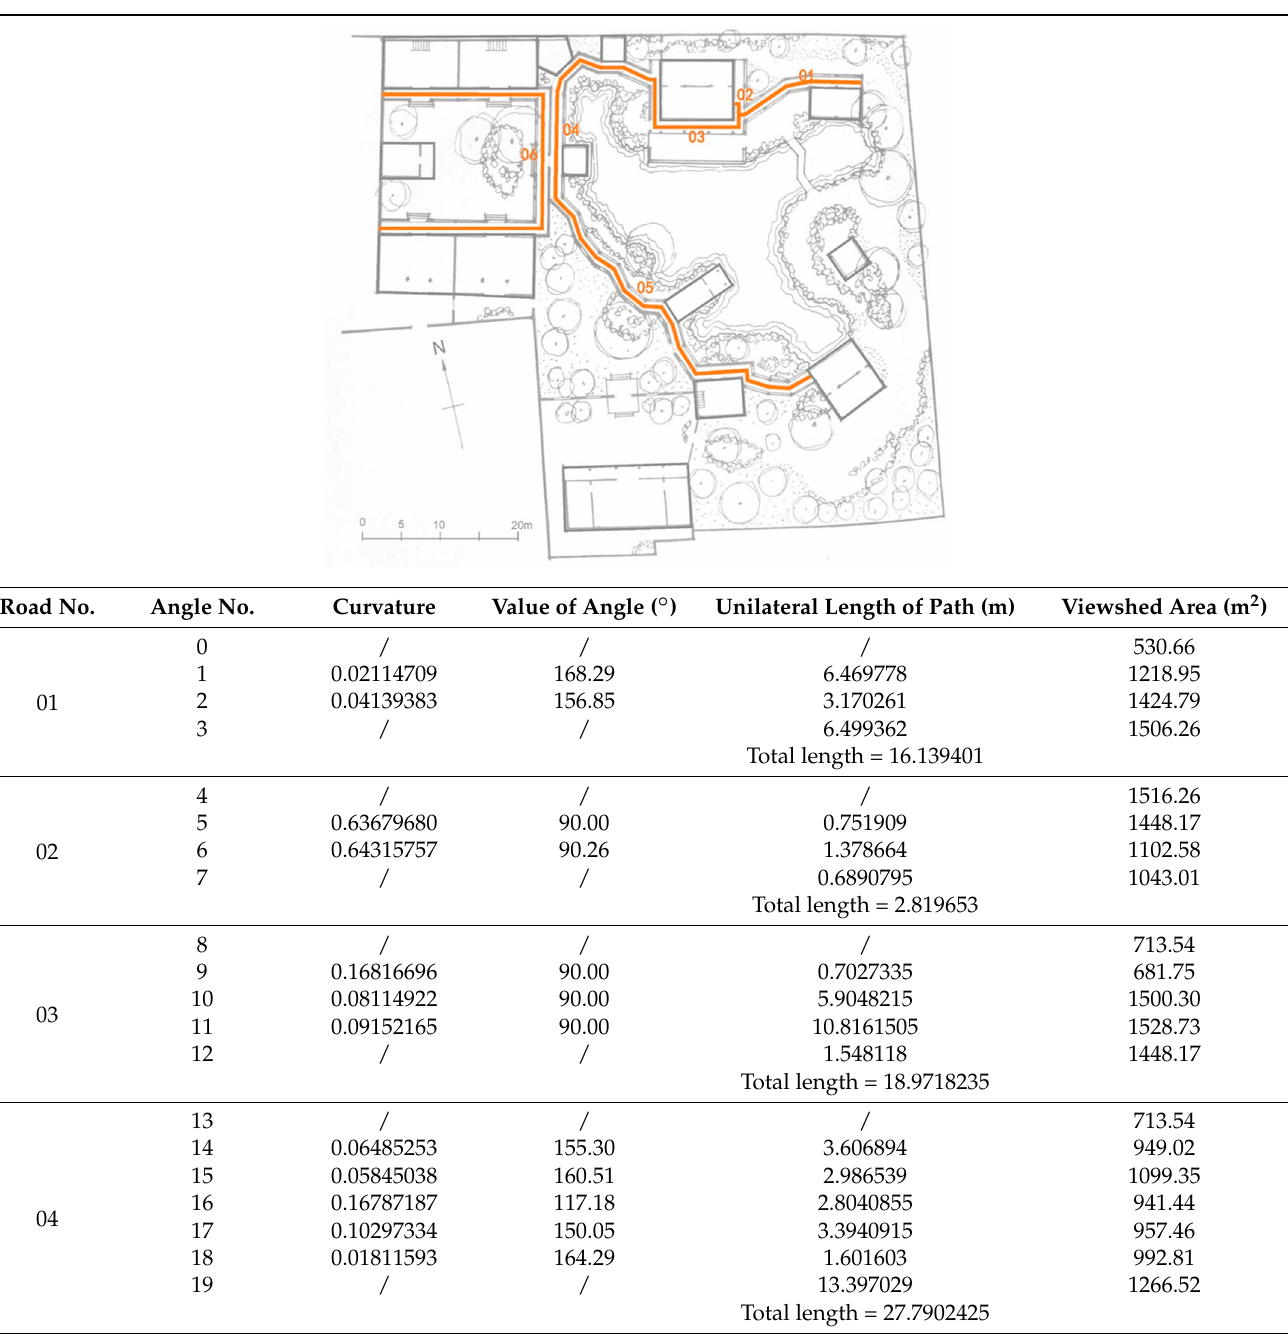
Table A17. Retreat and Reflection Garden, corridor.